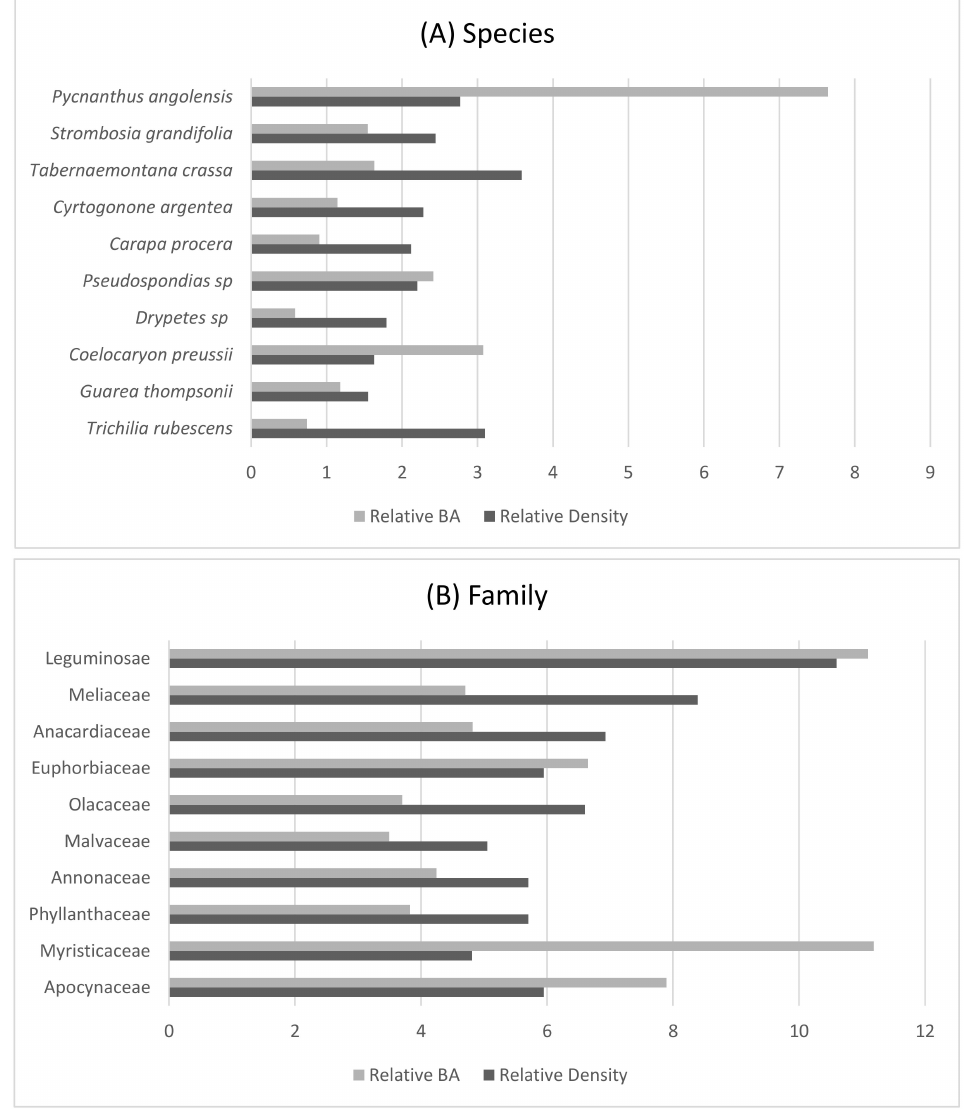
Figure 3. Structure and composition of gorilla nesting area habitat by ( A ) the ten species with the highest importance values and ( B ) the ten families with the highest importance